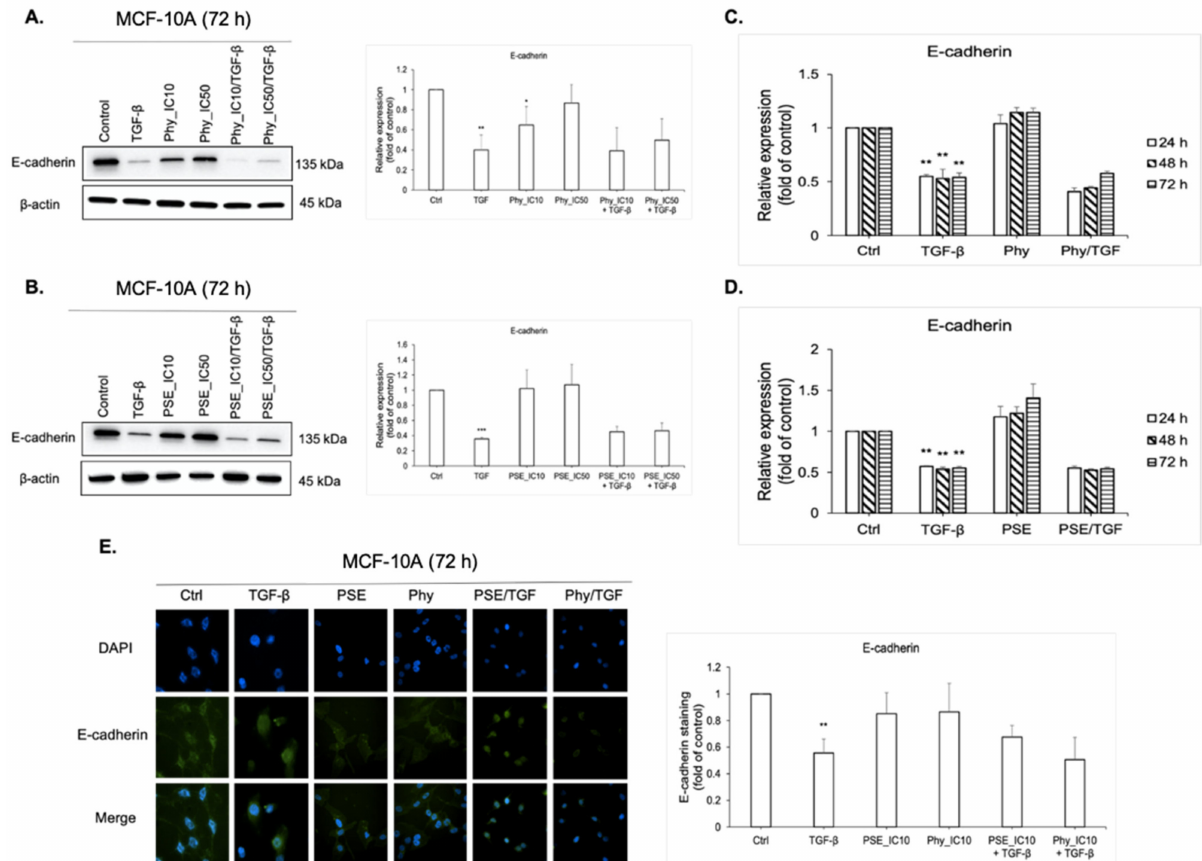
Figure 7. E-cadherin expression in MCF-10A cells after PSE and Phy treatment. The protein levels of EMT epithelial marker E-cadherin were assayed by Western blot analysis using IC 10 and IC 50 concentrations of Phy ( A ) and PSE ( B ). The band intensities of target protein were measured using the Image Studio Lite software. Quantification is relative to the control and normalised to β -actin expression. Flow cytometry analysis of E-cadherin expression after 24, 48 and 72 h treatment of IC 10 of Phy ( C ) and PSE ( D ). ( E ) Representative fluorescence microscopy images of E-cadherin expression in MCF-10A cells after 72 h treatment of IC 10 PSE and Phy. The green signal represents corresponding protein staining by Alexa Fluor 488 and the blue signal indicates nuclei staining by DAPI. Original magnification x200. The fluorescence staining of N-cadherin was analysed using ImageJ software. Quantification is relative to the control. Data in graphs are shown as mean ± SD for three separate experiments. * p < 0.05, ** p < 0.01, *** p < 0.001 compared to control; ∆ p < 0.05, ∆∆ p < 0.01, ∆∆∆ p < 0.001 compared to TGF- β